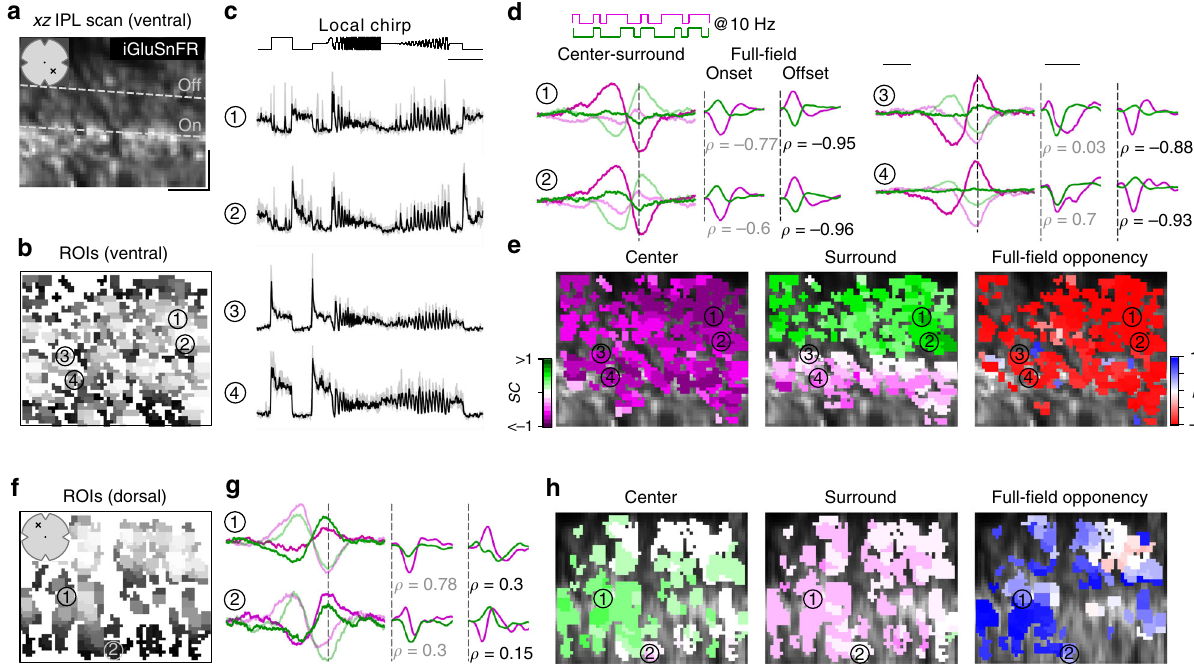
Fig. 3 Recording chromatic bipolar cell responses across the inner plexiform layer. a Vertical (xz) scan fi eld (48 × 50 µ m, 11.17Hz) located in the ventral retina showing iGluSnFR expression across the inner plexiform layer (IPL). Dotted lines indicate On and Off ChAT band, respectively. x and y scale bars: 10 µ m. b ROI mask for scan fi eld shown in a . For details on ROI detection, see Methods. c Mean glutamate traces (black, s.d. shading in gray; n = 5 trials) of ROIs indicated in b in response to a local chirp stimulus (scale bar: 5 s). d Temporal center (bright) and surround (dim) kernels (event-triggered average) estimated from a 10 Hz center-surround fl icker stimulus of UV and green LED (left, scale bar: 200 ms) and mean glutamate events (stimulus-triggered event) in response to onset and offset of a full- fi eld UV and green stimulus (right, scale bar: 0.5 s) for ROIs indicated in b . Linear correlation coef fi cient ( ρ ) of mean glutamate events indicated below traces. For further analysis, min( ρ onset , ρ offset ) indicated in black is considered as full- fi eld opponency (Methods). Dotted lines indicate time point of response/stimulus onset/stimulus offset. e ROI mask from b color-coded according to center (left) and surround spectral contrast (SC) (middle) as well as full- fi eld opponency (right). f ROI mask of a scan fi eld located in the dorsal retina. g , h Like d , e , but for dorsal scan fi eld shown in f . Scan fi elds/traces shown in this fi gure correspond to representative examples. In total, we recorded n = 21 scan fi elds in n = 5 mice. For quanti fi cation, see Fig.